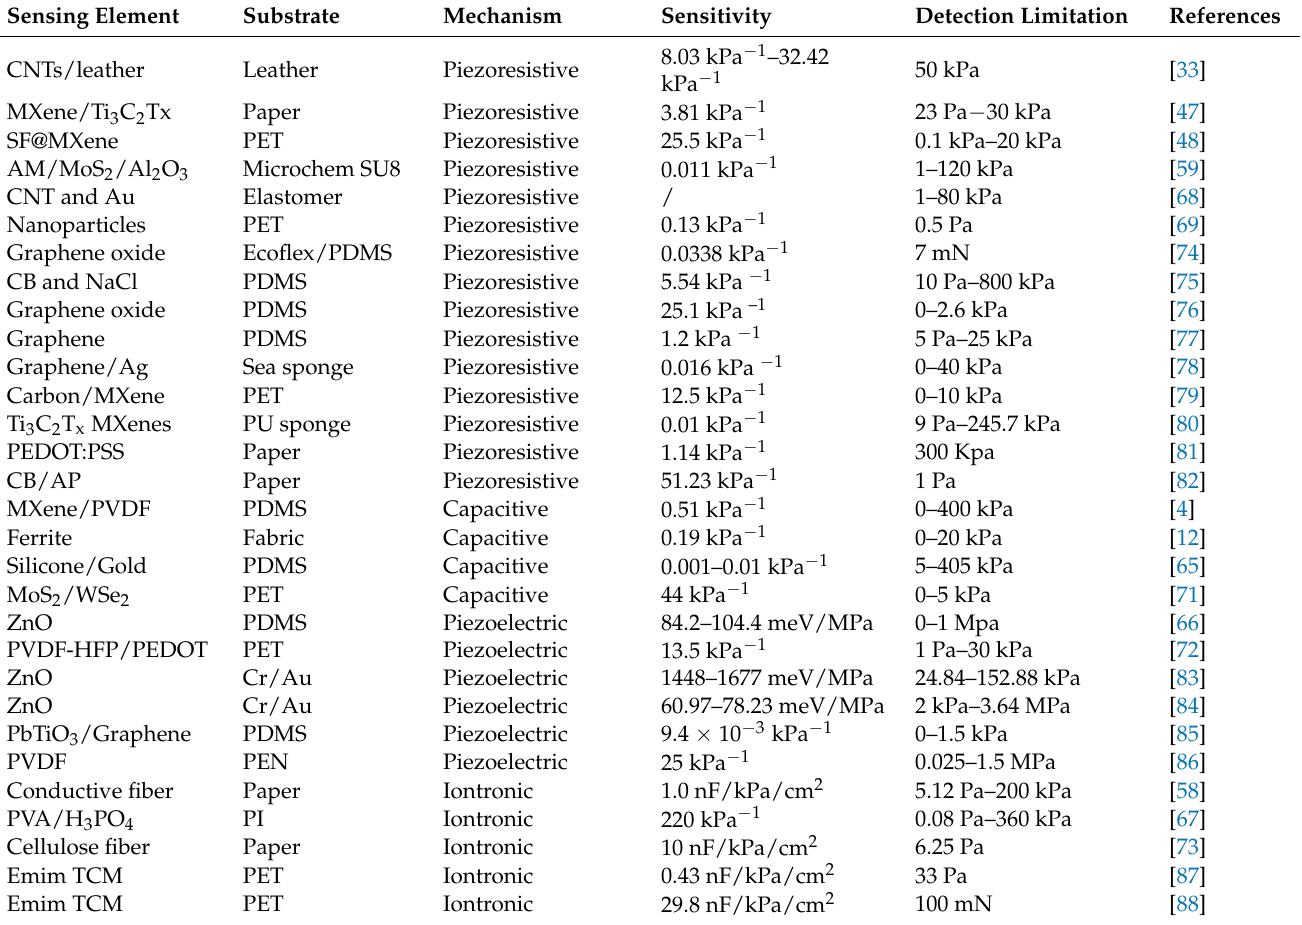
Table 1. Summary of main characteristic parameters of pressure sensors based on sensing elements and elastic